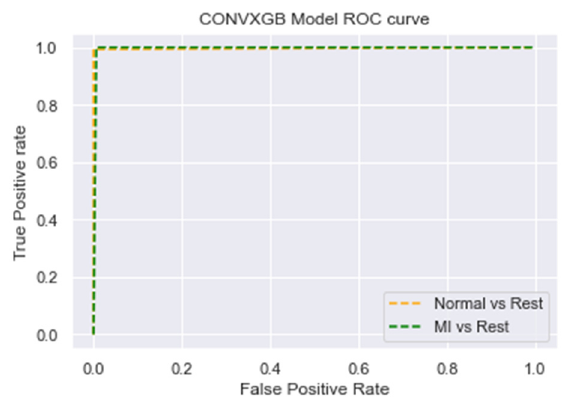
Figure 9. AUC of the ConvXGB model for another dataset.